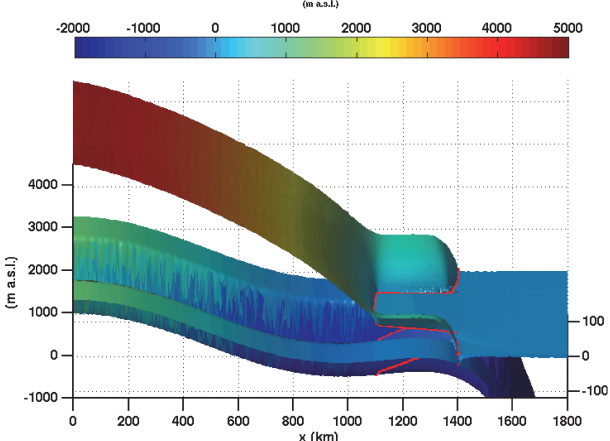
Fig. 3. A perspective plot of the steady-state geometry obtained with the numerical code ´Ua for a channel half-width of w c = 50km. Shown is the upper and lower glacier surface and the ocean ma − 1 bathymetry. The grounding line is drawn as a red line along the up- per and the lower glacier